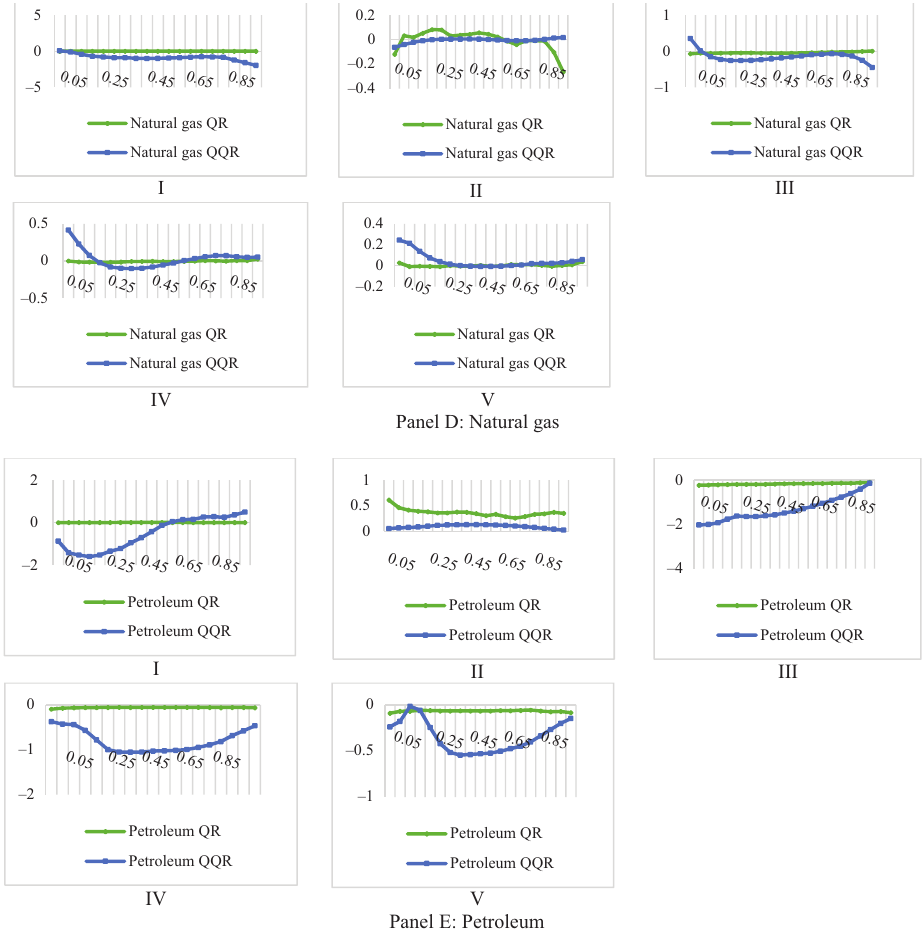
Figure 4. Line graphs of QR and QQR